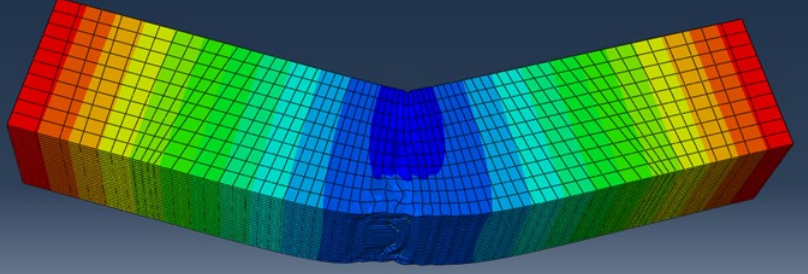
Figure 18. Contour diagrams of the displacement (along axis Y) of the specimen.